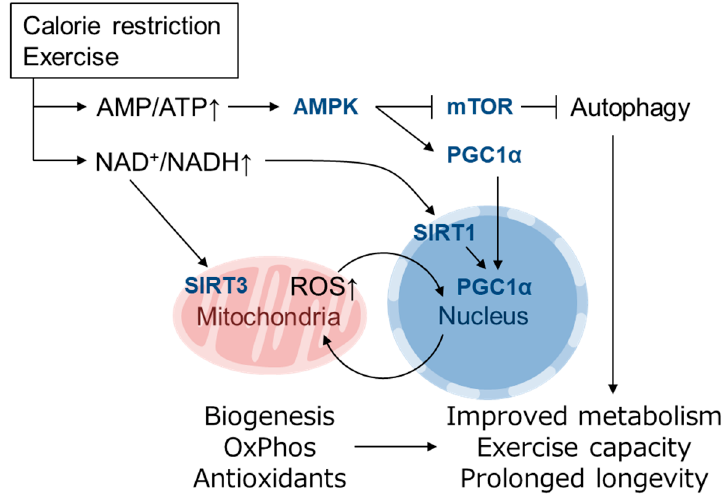
Figure 2. Mitohormesis caused by mild metabolic stress elicits an antioxidant defense response. Metabolic stress, such as caloric restriction and exercise, causes a decline in ATP levels and an